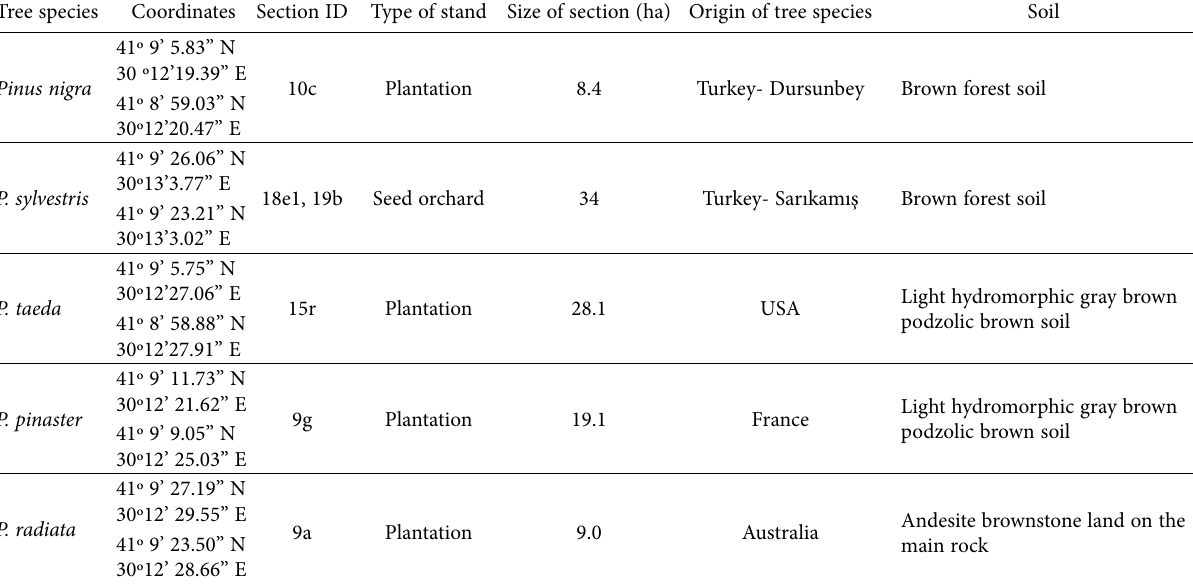
Table 1. Locations of pine plantings assessed for Diplodia shoot dieback. Tree species